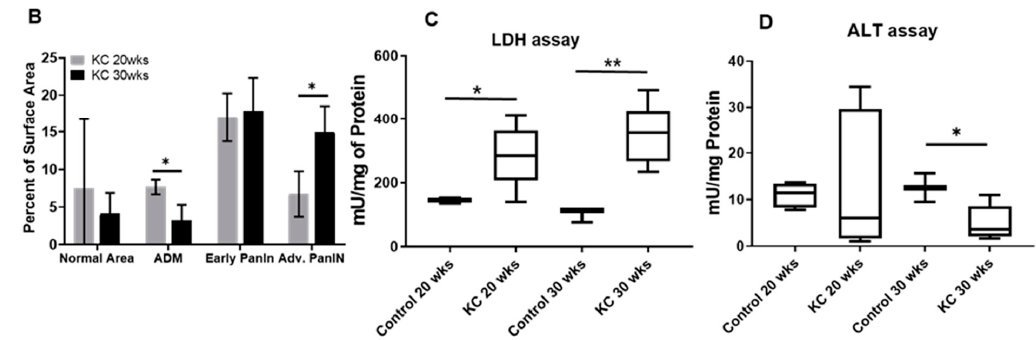
Figure 1. ( A ) Representative Hematoxylin and Eosin (H&E) micrographs for different mice groups. Histological staining demonstrates the differences in morphology and cellularity in normal pancreas (control 20 wks) and early- (P48:Cre; LSL-KRAS G12D —KC; 20 wks) and advanced-stage (KC 30 wks) pancreatic intraepithelial neoplasias (PanINs). ( B ) Lesion quantification as presented by the percent of surface area varied with PanINs progression from early to advanced stage. Normalized values of active alanine transaminase (ALT) and lactate dehydrogenase (LDH) enzyme concentrations for different mice groups ( n =8) are shown in ( C ) and ( D ) respectively. Normal pancreas and early-stage PanINs demonstrate high concentration of ALT and low levels of LDH, whereas the advanced-stage PanINs show low concentration of ALT and high concentration of LDH measured in mU/mg unit. * means p < 0.05; ** means p < 0.001.